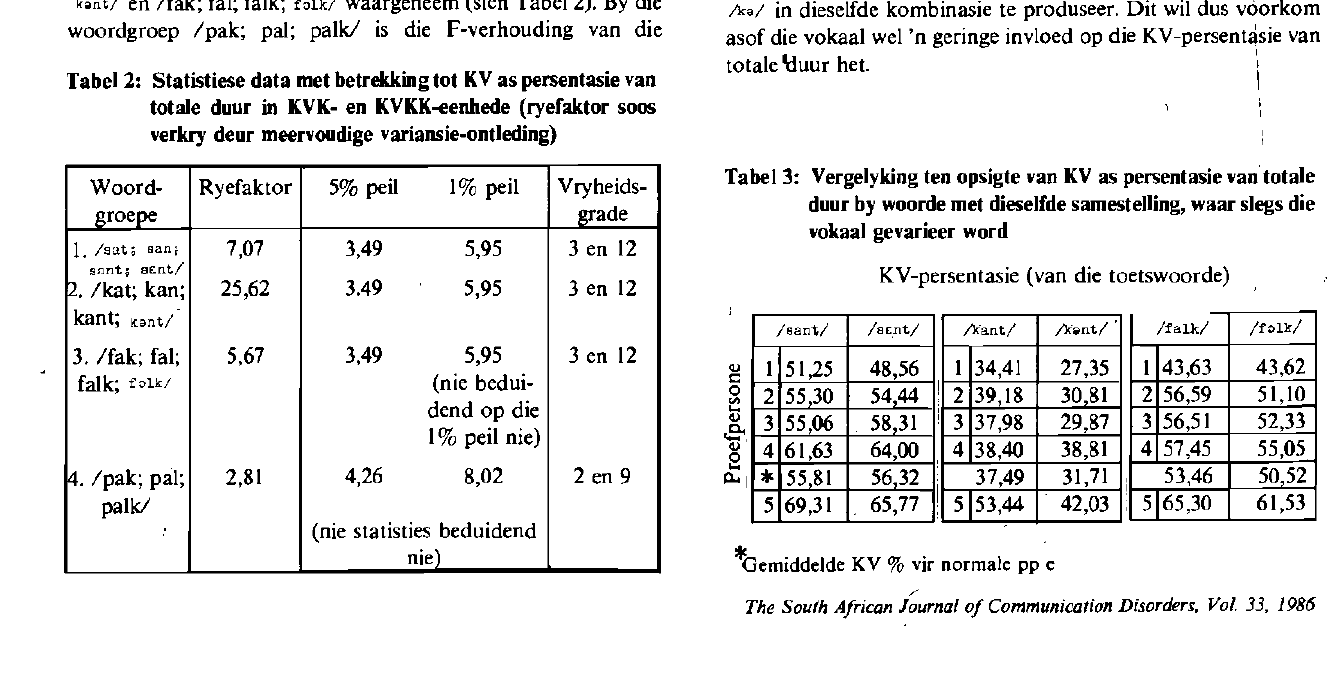
Tabel 2: Statistiese data met betrekking tot KV as persentasie van